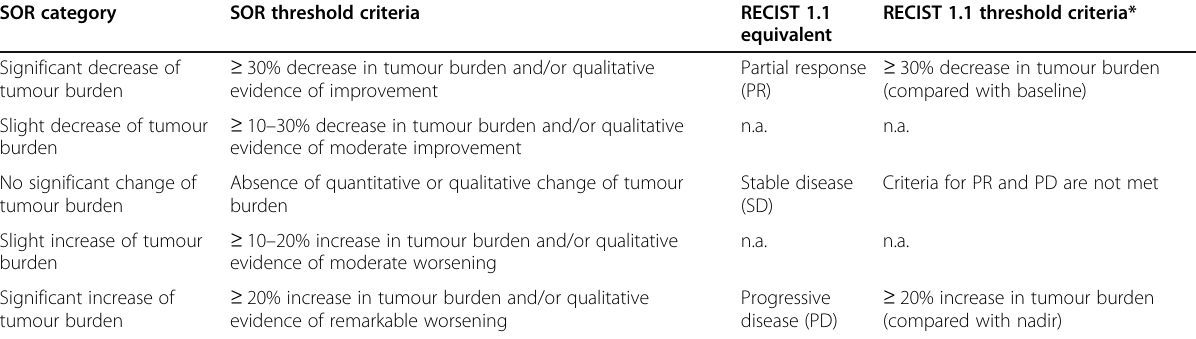
Table 1 Uniform terminology for tumour response categories SOR